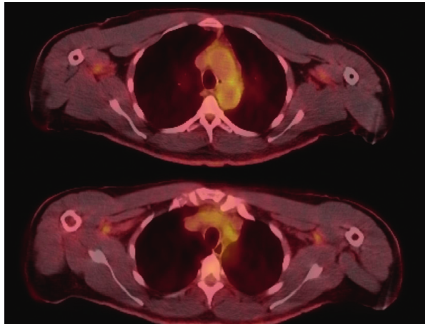
Figure 3: PET-CT shows FDG avidity of the vascular walls of the